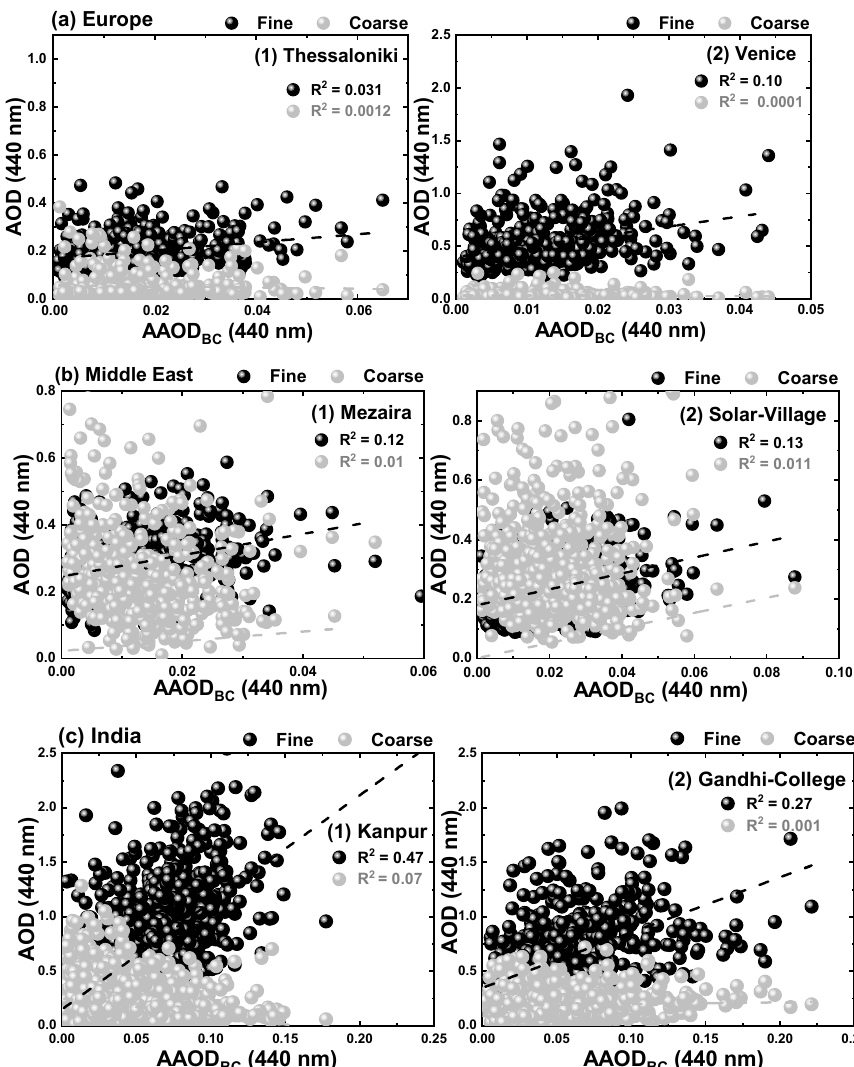
Figure 8. The coefficient of determination (R 2 ) between AAOD BC and AOD T at 440 nm for the fine mode (black circles) and the coarse mode (gray circles) at ( a ) the European, ( b ) Middle Eastern, and ( c ) Indian sites from 2000 to 2018.